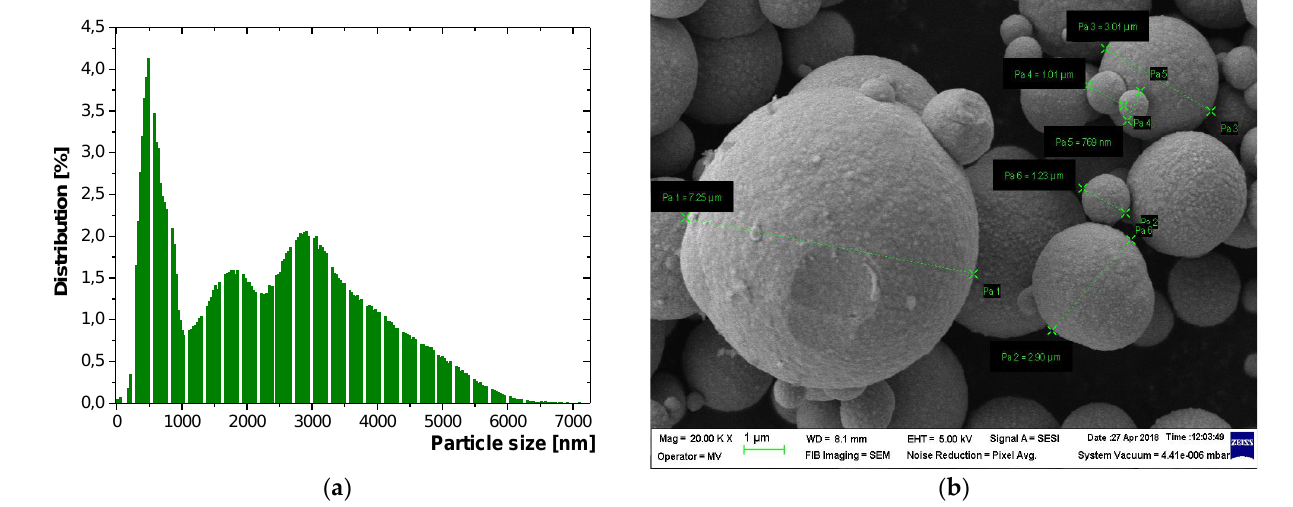
Figure 11. ( a ) Histogram — particle size distribution for Fe/800 nm powder ( b ) SEM image of Fe/800 nm powder.